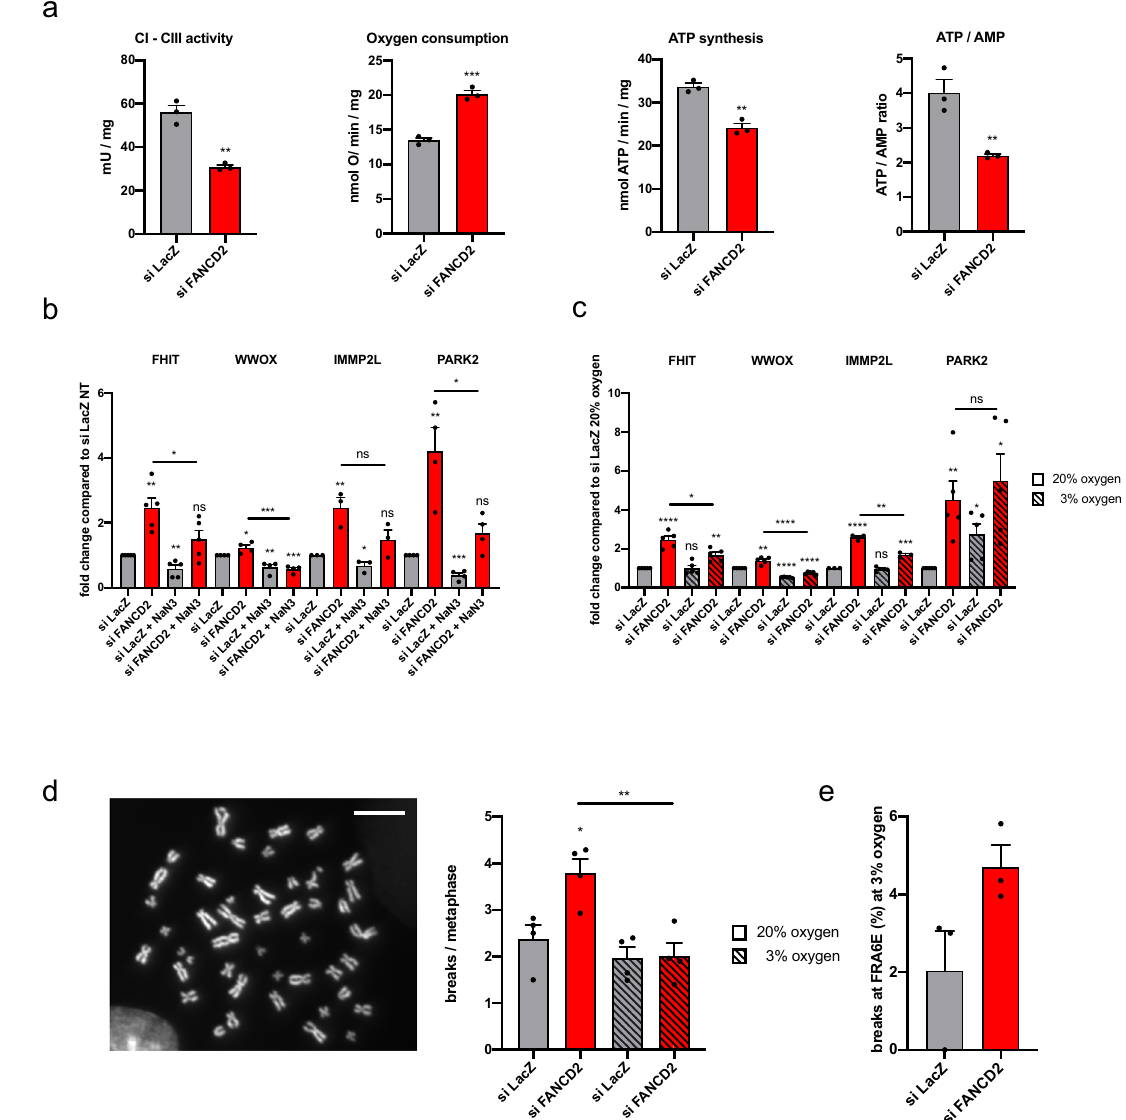
Fig. 4 CFS expression and breakage is associated with OXPHOS dysfunction. a Parameters for mitochondrial activity and cellular energy status analyzed after control or FANCD2 siRNA transfection. n = 3 independent experiments. ** p = 0.0015 (CI – CIII activity); *** p = 0.0004 (oxygen consumption); ** p = 0.0017 (ATP synthesis); ** p = 0.008 (ATP/AMP ratio). b RT-qPCR-based analysis of CFS gene expression in cells after control or FANCD2 siRNA transfection and treated or not with 20 mM NaN3 for 10 h. n = 5 (FHIT), n = 4 (WWOX), n = 3 (IMMP2L), n = 4 (PARK2) independent experiments. ** p = 0.0017 (FHIT_siFANCD2), ** p = 0.0052 (FHIT_siLacZ_NaN3), * p = 0.0491 (FHIT_siFANCD2_NaN3 vs. FHIT_siFANCD2), * p = 0.0288 (WWOX_siFANCD2), ** p = 0.006 (WWOX_siLacZ_NaN3), *** p = 0.0002 (WWOX_siFANCD2_NaN3), *** p = 0.0005 (WWOX_siFANCD2_NaN3 vs. siFANCD2), ** p = 0.0091 (IMMP2L_siFANCD2), * p = 0.0464 (IMMP2L_siLacZ_NaN3), ** p = 0.0047 (PARK2_siFANCD2), *** p = 0.0002 (PARK2_siLacZ_NaN3), * p = 0.0184 (PARK2_siFANCD2_NaN3 vs. PARK2_siFANCD2). c RT-qPCR analysis of CFS gene expression after control or FANCD2 siRNA transfection of cells maintained at 20% or 3% oxygen. n = 5 (FHIT), n = 5 (WWOX), n = 3 (IMMP2L), n = 5 (PARK2) independent experiments. **** p < 0.0001 (FHIT_siFANCD2_20%), ** p = 0.0019 (FHIT_siFANCD2_3%), * p = 0.011 (FHIT_siFANCD2_3% vs. FHIT_siFANCD2_20%),